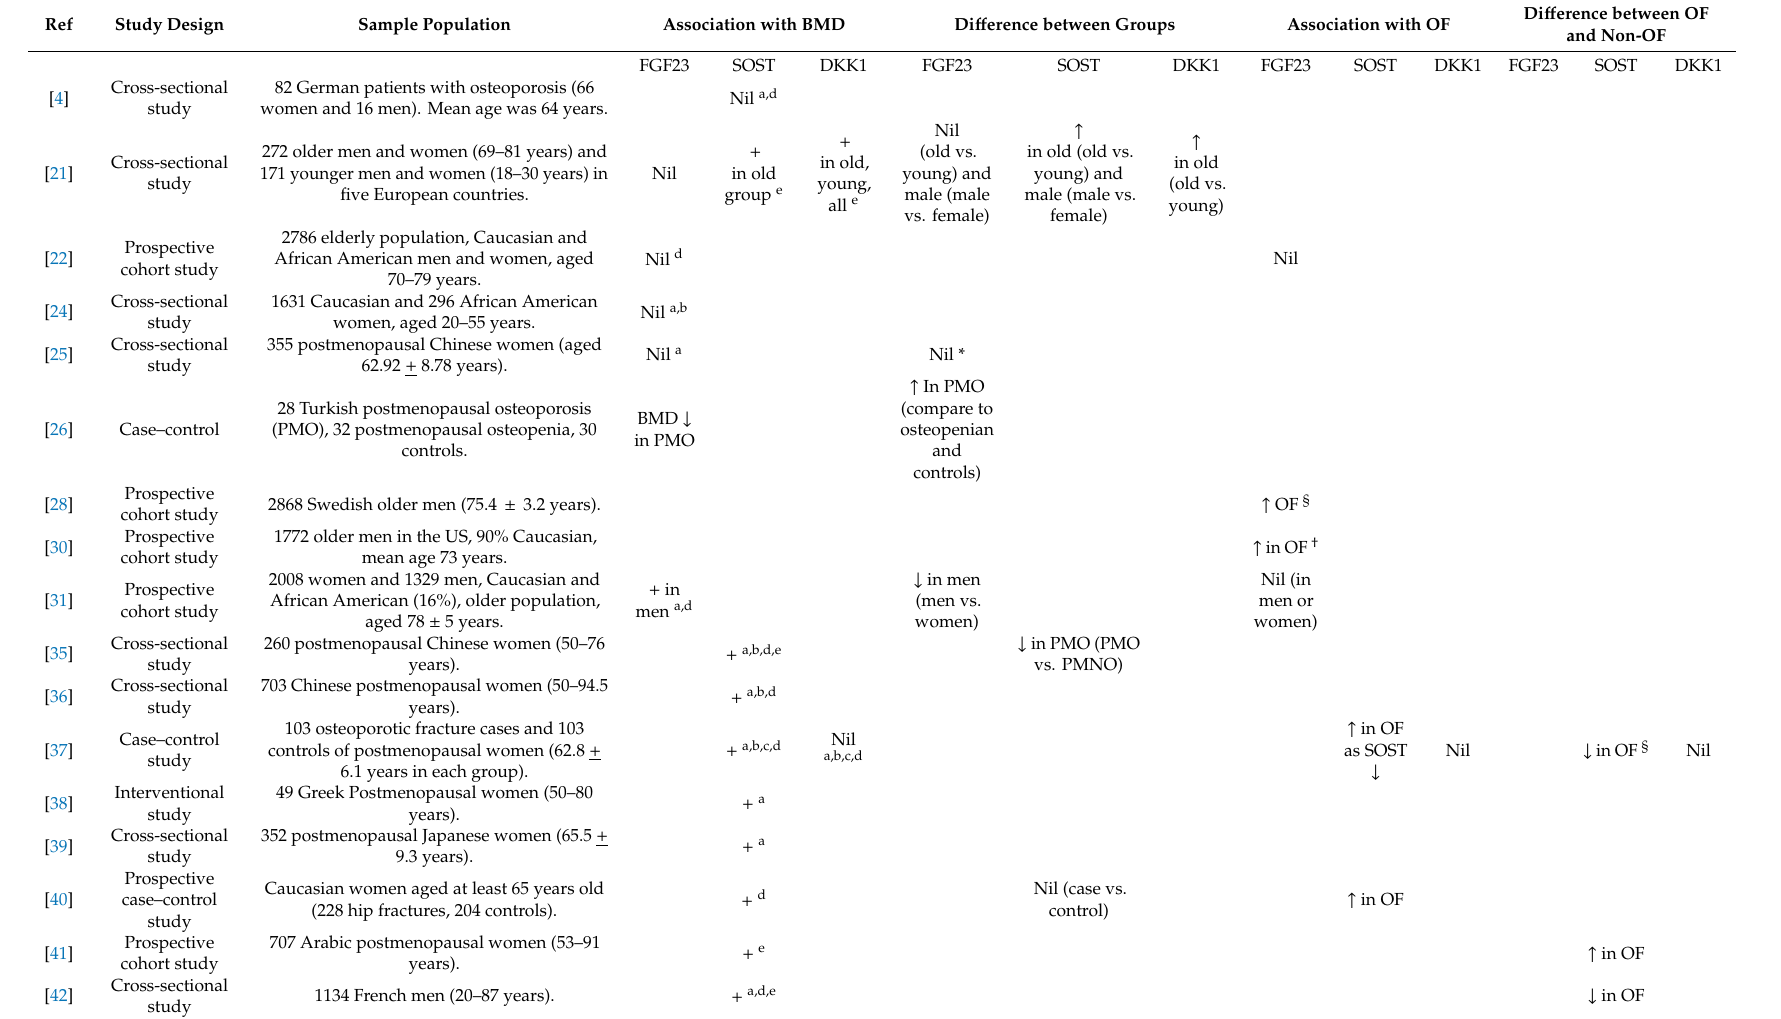
Table 1. The relationship between osteocyte markers and bone mineral density or osteoporotic